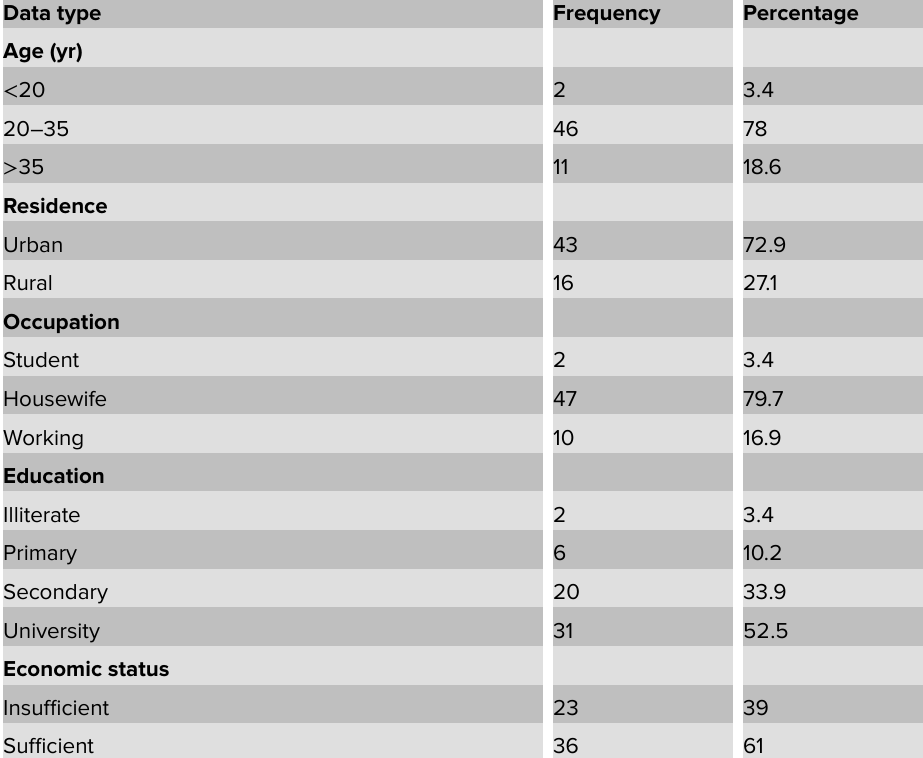
Table 1: Demographic data of the participants, n = 59.